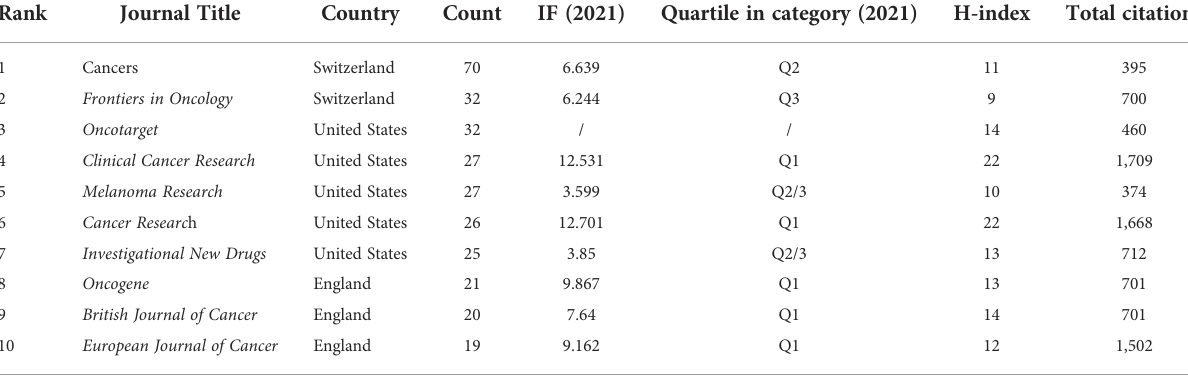
TABLE 4 The top 10 journals of research ranked by publication